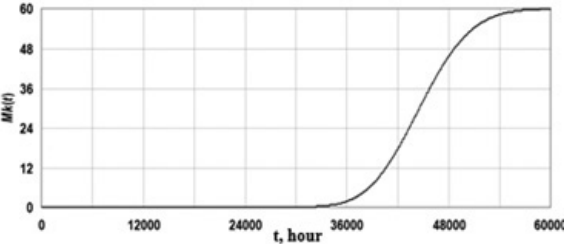
Figure 4. Forecast of the average number of failed flowmeters depending on the system operation